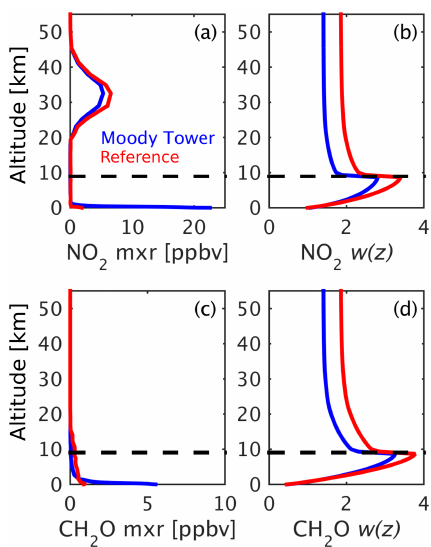
Figure 2. Sample mixing ratio (mxr) and scattering weight ( w(z) ) profiles used in the GCAS AMF calculations. The reference spec- trum profiles are taken from the 6 September afternoon flight over the Gulf of Mexico at an average location of 29.126 ◦ N, 94.818 ◦ W at 17:04LT (local time: UTC time − 5h) with SZA = 58.0 ◦ and VZA = 10.5 ◦ . The profiles at the Moody Tower site in downtown Houston are from the 25 September morning flight at 10:56LT with SZA = 45.0 ◦ and VZA = 10.7 ◦ . The estimated surface reflectivities at 442nm (NO 2 ) and 342nm (CH 2 O) are 0.04 and 0.05 at the refer- ence location and are both 0.07 at Moody Tower. The dashed black line indicates the aircraft flight